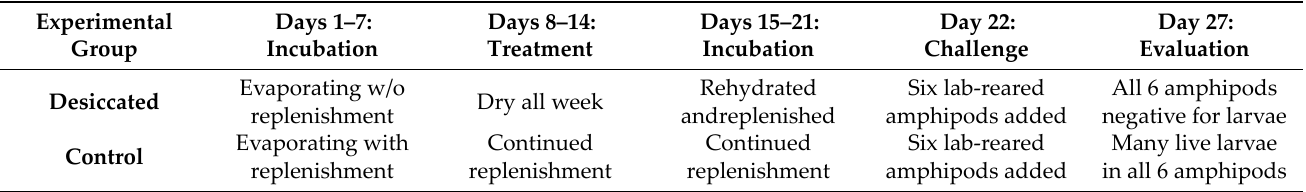
Table 2. Effects of desiccation on the ability of Huffmanela huffmani eggs to infect amphipods ( Hyalella cf. azteca